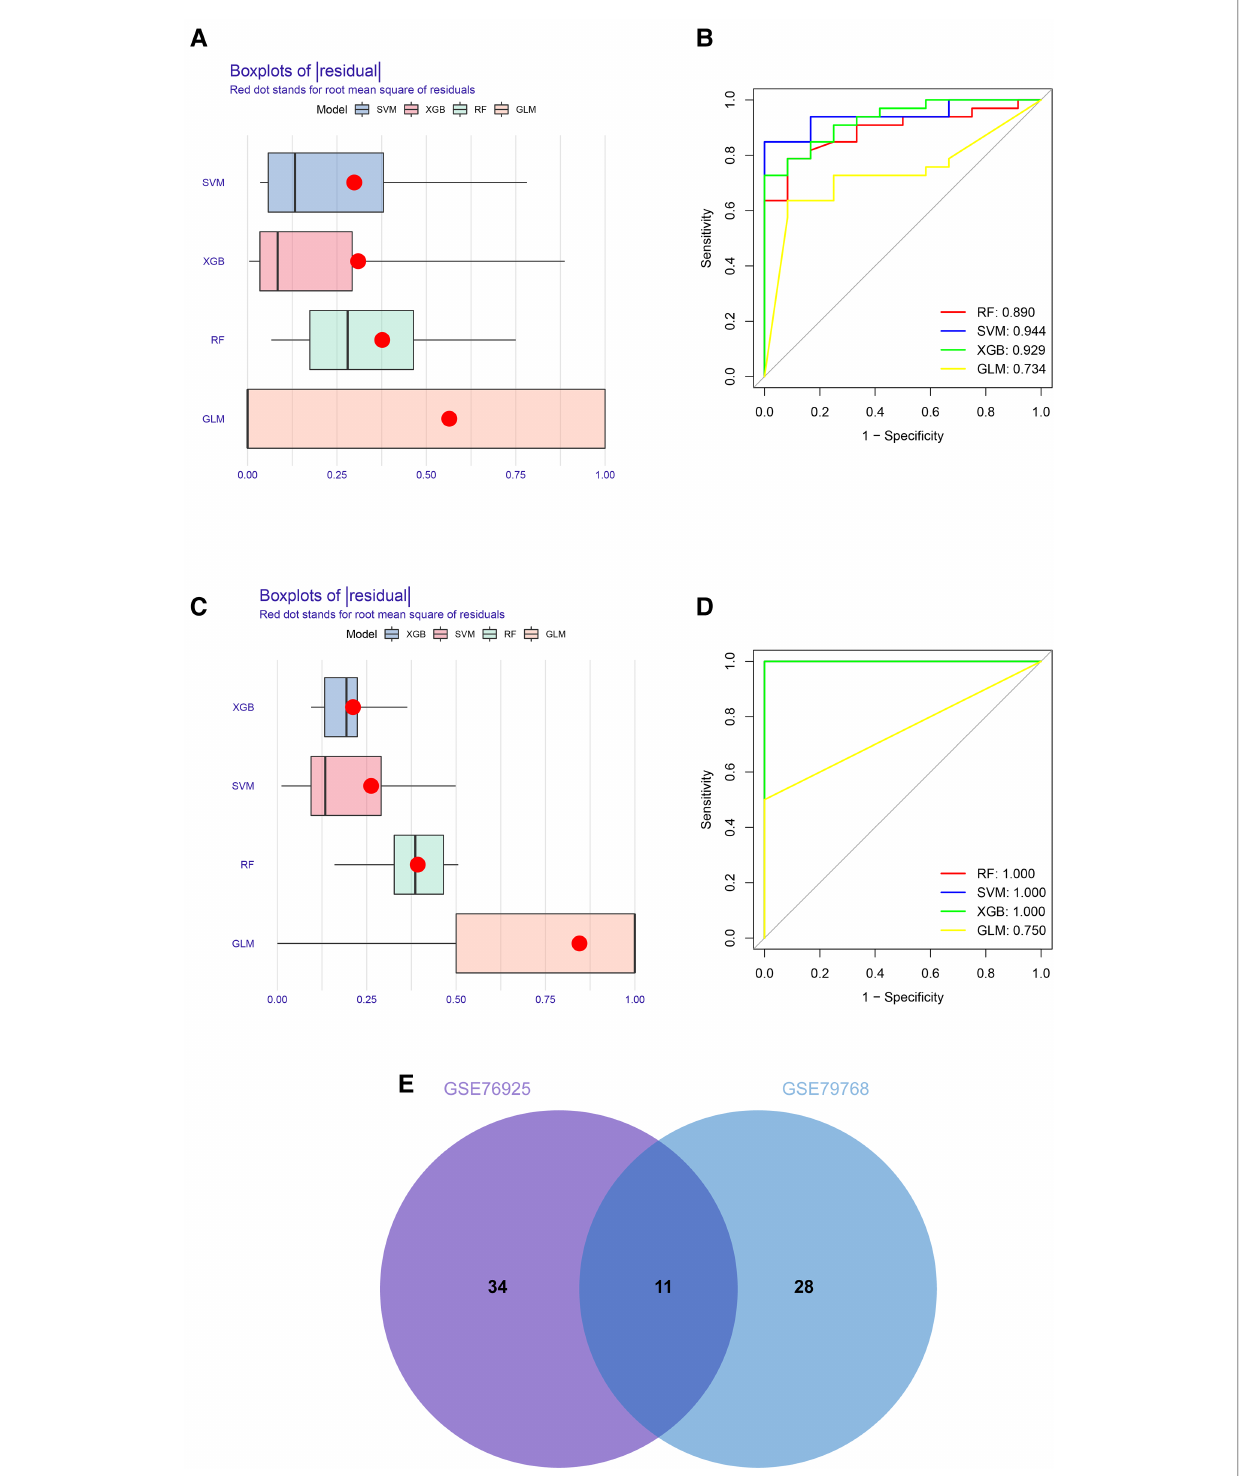
FIGURE 4 Construction and assessment of machine learning models for COPD and AF. ( A ) Boxplots of the residuals of the COPD. Red dot stands for root mean square of residuals. ( B ) ROC curves for model prediction accuracy in COPD dataset. ( C ) Boxplots of the residuals of the AF. ( D ) ROC curves for model prediction accuracy in AF dataset ( E ) Venn diagram of COPD and AF model prediction